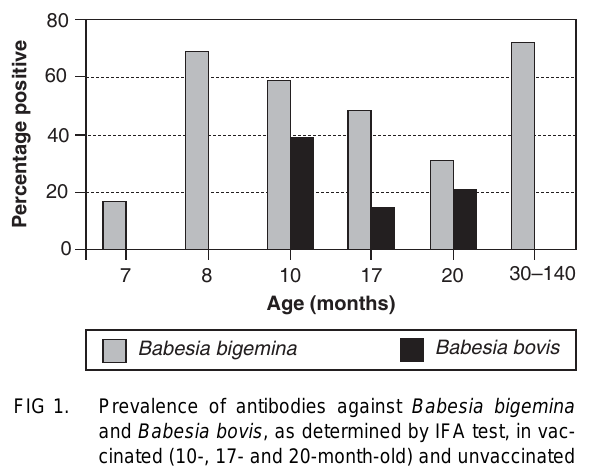
FIG 1. Prevalence of antibodies against Babesia bigemina and Babesia bovis , as determined by IFA test, in vac- cinated (10-, 17- and 20-month-old) and unvaccinated (7-, 8- and 30–140-month-old) Brahman cattle at Nooit- gedacht